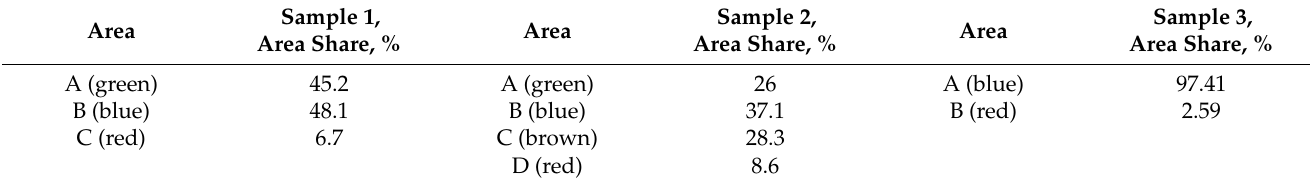
Table 2. Distribution of the area share (%) for different characteristic areas of elements: sample 1 (Figure 4(a2)), sample 4 (Figure 4(b2)), sample 3 (Figure 4(c2)).